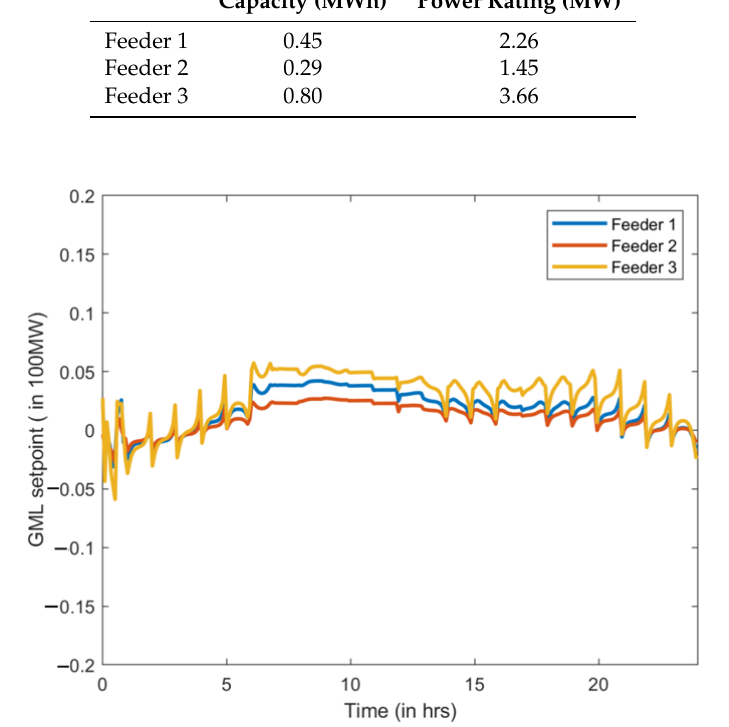
Figure 16. The 24-h GML real power set-point trajectory for three fully modelled feeders starting from 11:00 in the peak-shaving